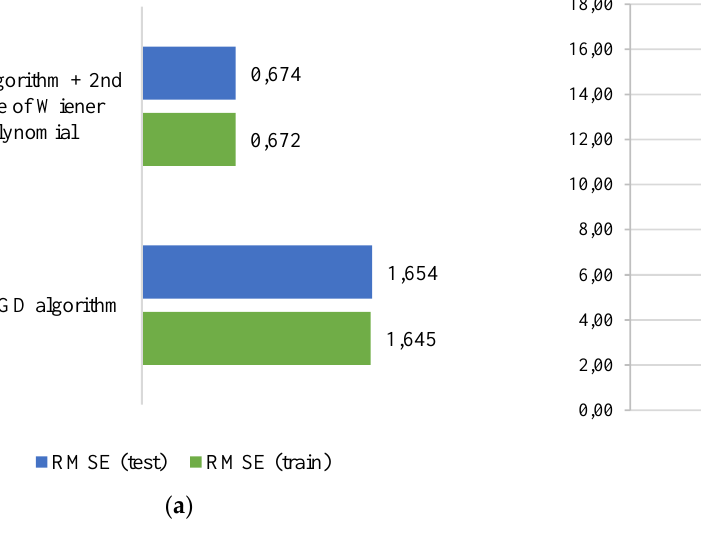
Figure 5. Influence of the Wiener polynomial degree on the performance of the SGD algorithm: ( a ) RMSE; ( b ) training time, seconds.